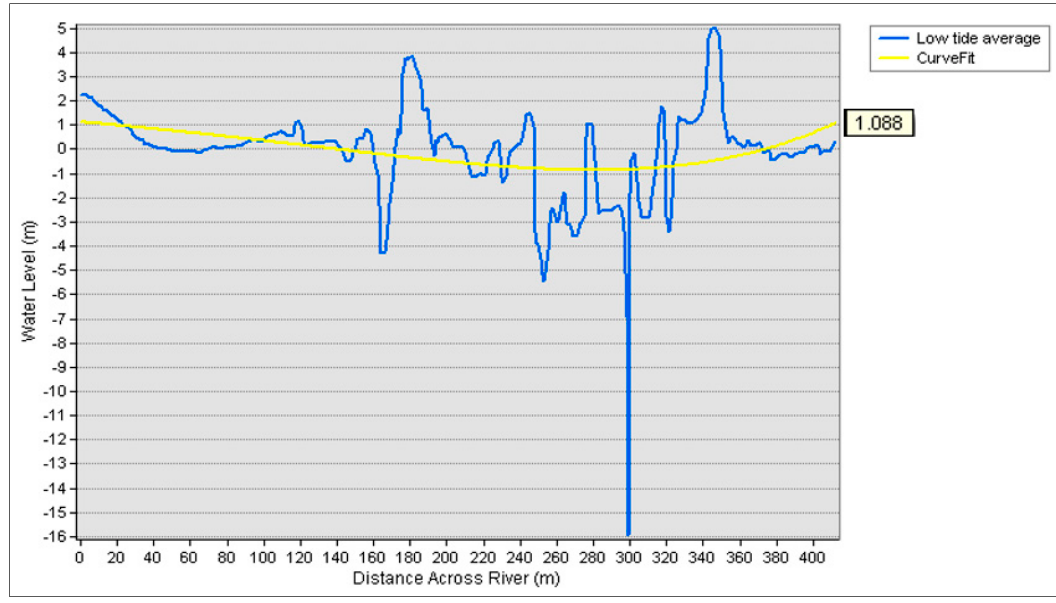
Figure 13. Low tide average against tidal value at cross section 1.